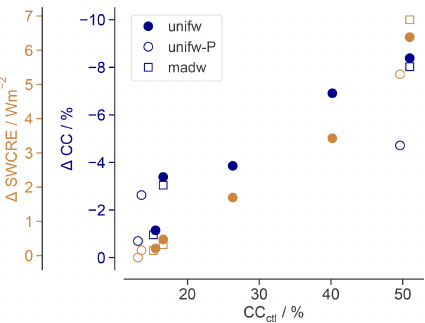
Figure 8. Relationship between cloud cover amount in the control simulation (CC ctl ) and cloud cover reduction with warming ( (cid:49) CC) as well as (cid:49) SWCRE across all simulations.